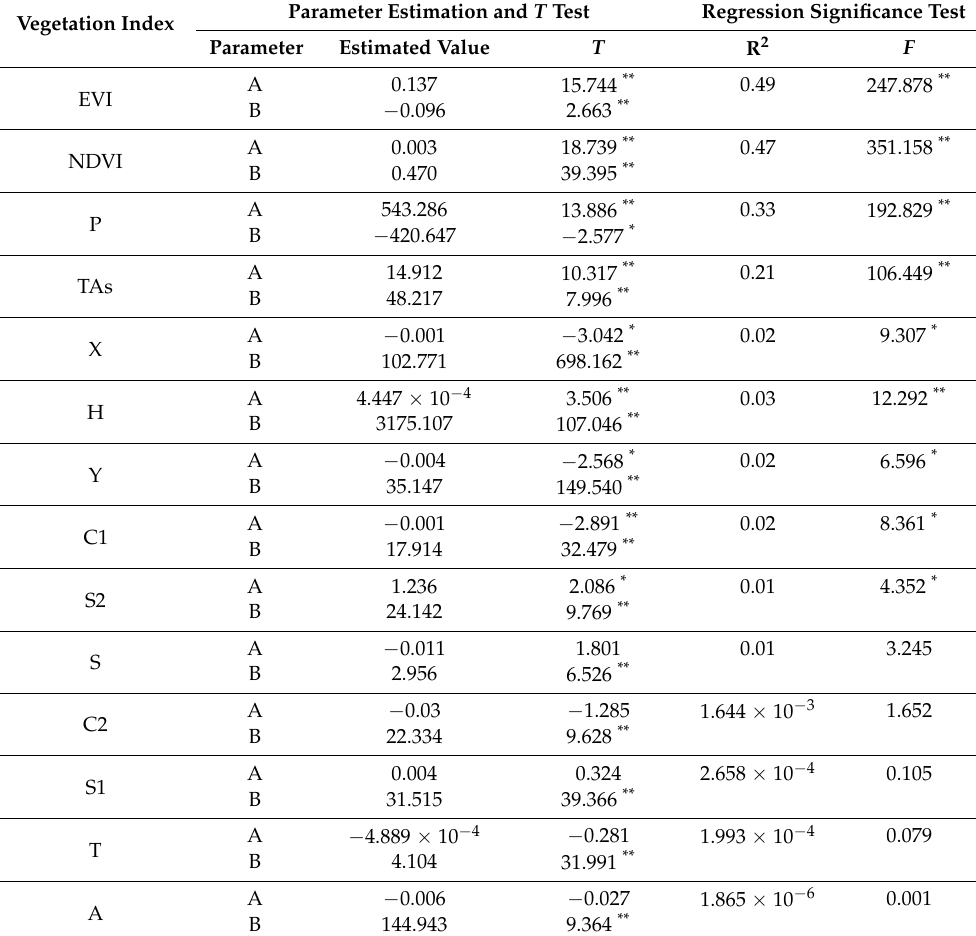
Table 4. Results of model fitting with the optimum inversion models based on a single factor. Vegetation